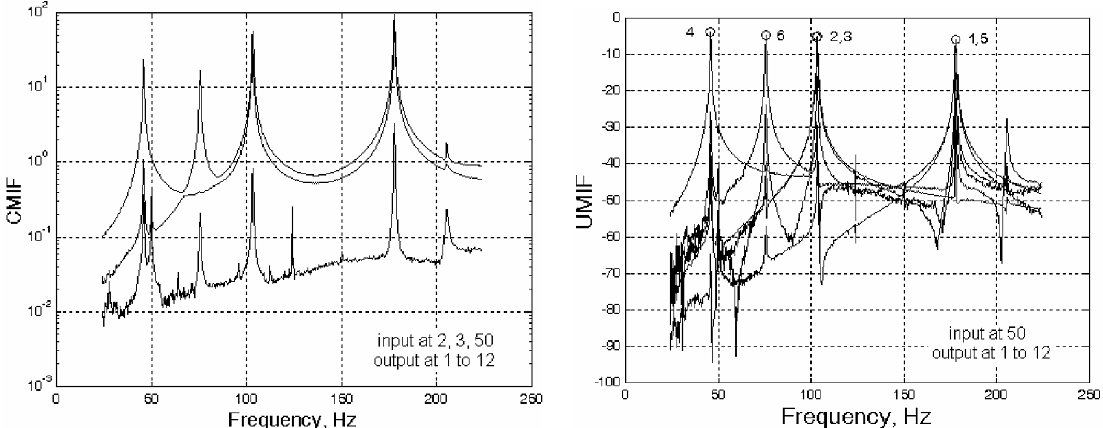
Fig. 20. CMIF for the test structure. Fig. 21. UMIF for the test structure.